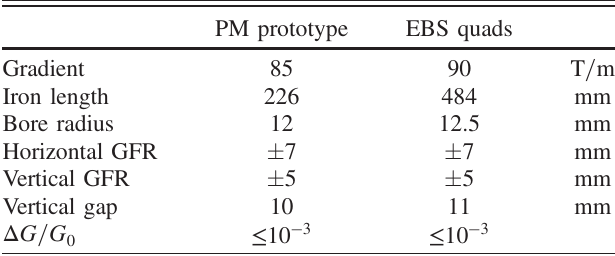
TABLE I. High gradient quadrupole specifications for the PM prototype described here and the EBS quadrupoles. The GFR is